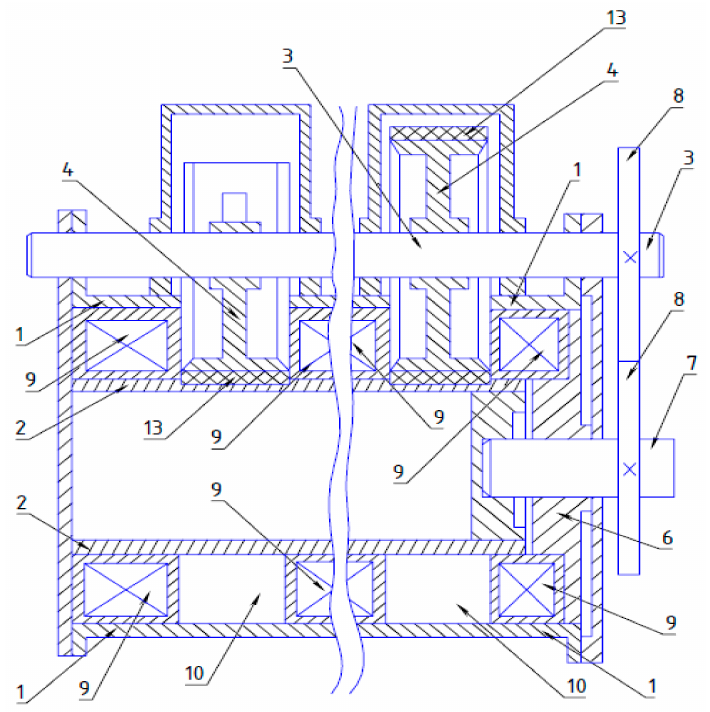
Figure 15. Sketch of the general view of the volume-sectional hydraulic